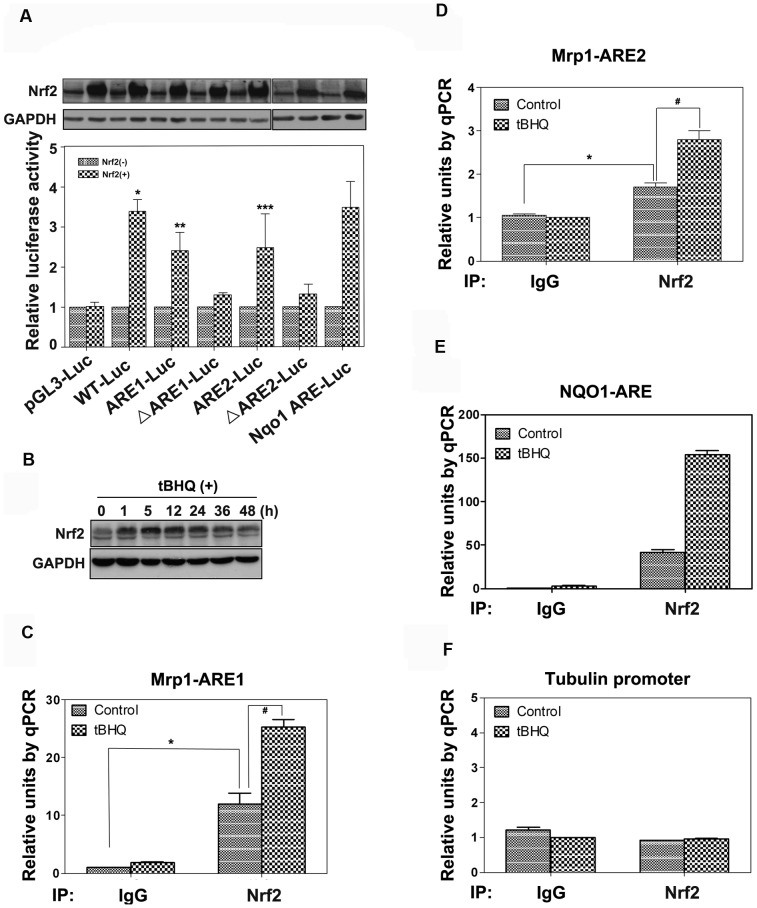
Nrf2-mediated induction of Mrp1 promoter activity depends both on ARE1 and ARE2 in 231 cells.(A) 231 cells were transfected with five luciferase reporter constructs (wt-Luc, ARE1-Luc, ARE2-Luc, ΔARE1-Luc and ΔARE2-Luc), and promoterless pGL3-basic (pGL3-Luc), NQO1-ARE-Luc and pRL-TK were used as negative control, positive control and internal control, respectively. The aforementioned plasmids were co-transfected with or without Nrf2-expression plasmid. After 48 hours, cells were harvested and luciferase activities were measured with a dual-luciferase assay system (lower panel). Data were means ± SD of values from three independent experiments. The equal amount of transfection of Nrf2 was assured by western Blot (upper panel). (B) 231 cells were treated with 40 µM tBHQ for the indicated time point, and then were harvested to be subjected to immune blot to measure Nrf2 protein level. Experiments were performed three times and a representative immunoblot was shown here. (C), (D), (E) and (F) 231 cells were treated or not with 40 µM tBHQ for 24 h and were cross-linked with formaldehyde. Sonicated chromatin was subjected to immunoprecipitation with antibodies against Nrf2 or normal IgG. Precipitated DNA was followed by realtime PCR analysis with primers against Mrp1 ARE1 (panel C), Mrp1 ARE2 (panel D), NQO1 ARE (panel E) and Tubulin promoter (panel F). Experiments were performed three times and a representative of three experiments was shown here.